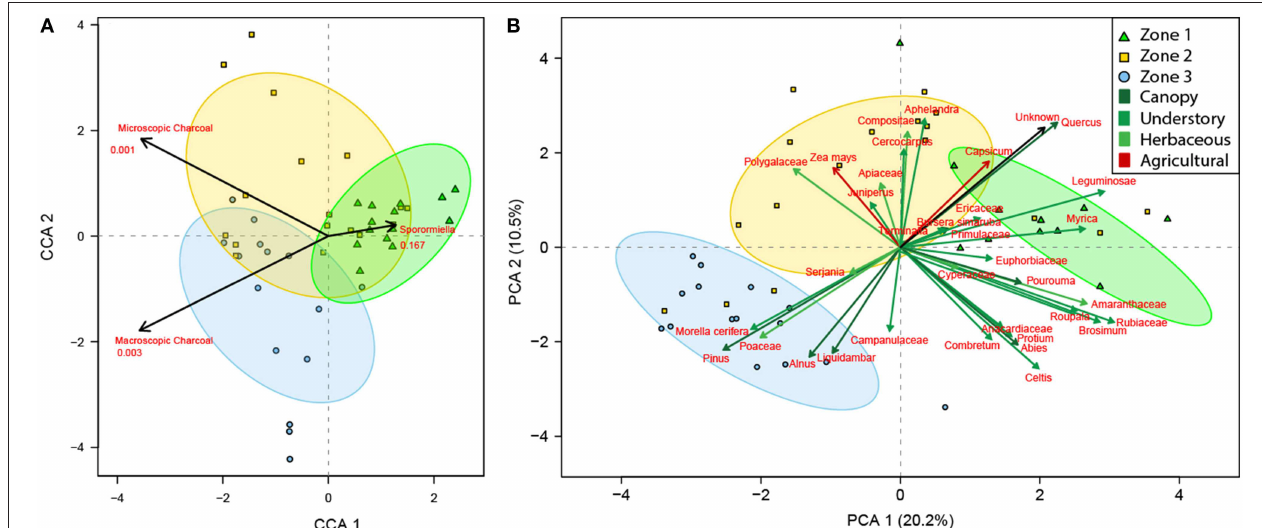
FIGURE 4 | Canonical correspondence analysis of the palaeopalynological data set ordinated against independent environmental indicators of local fire (macroscopic charcoal), regional fire (microscopic charcoal), and herbivory ( Sporormiella ) (A) . Principal component analysis of the palaeopalynological data set (B) . Zones are derived from the broken stick model and are represented by ellipses at a confidence of 95%. Zone 1 = green triangles; Zone 2 = yellow squares; Zone 3 = blue circles.